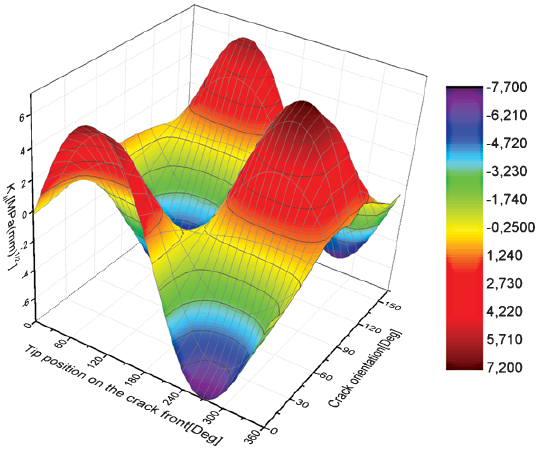
Fig. 15. K II distribution on the crack front as function of the crack orientation in the pos1 in cement mantle.